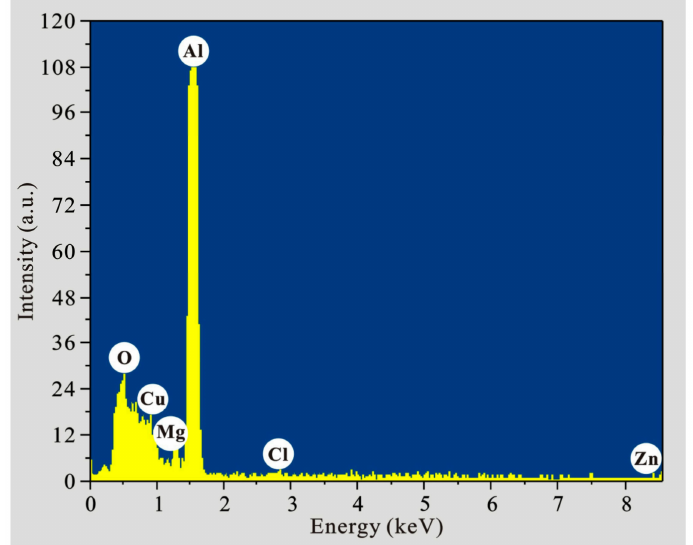
Figure 4. EDS analysis of 7075 aluminum alloy after etching for 7